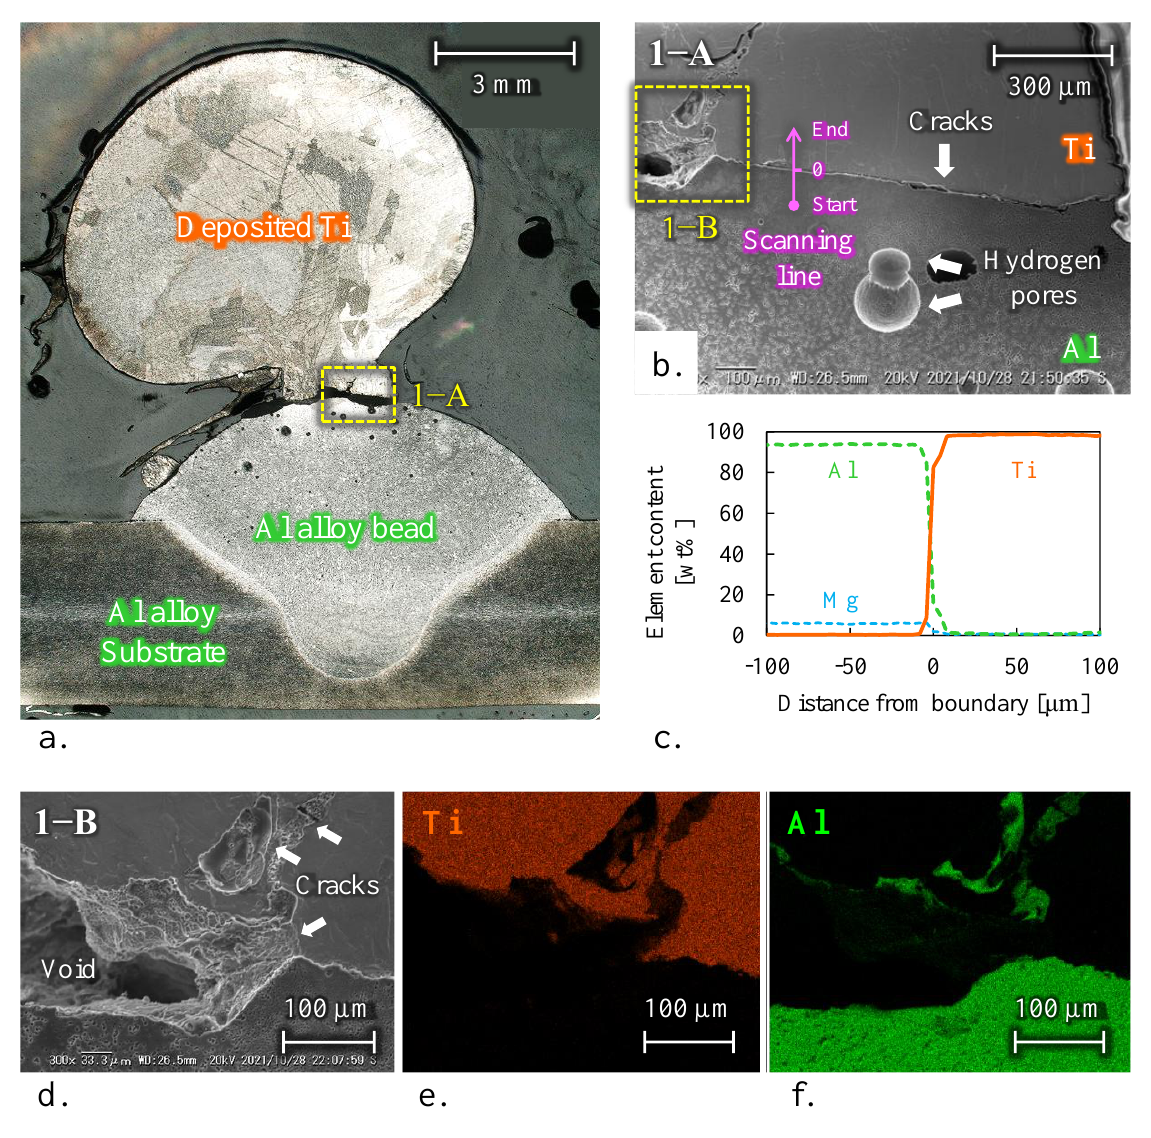
Figure 4. Ti onto single Al alloy bead using fabrication condition No. 7; ( a ) Overview. ( b ) Area 1 − A: Ti/Al interface. ( c ) Result of EDS-linear analysis. ( d ) Area 2 − B: void and cracks on Ti/Al interface. EDS map of area 2 − B corresponding to ( e ) Ti and ( f ) Al.